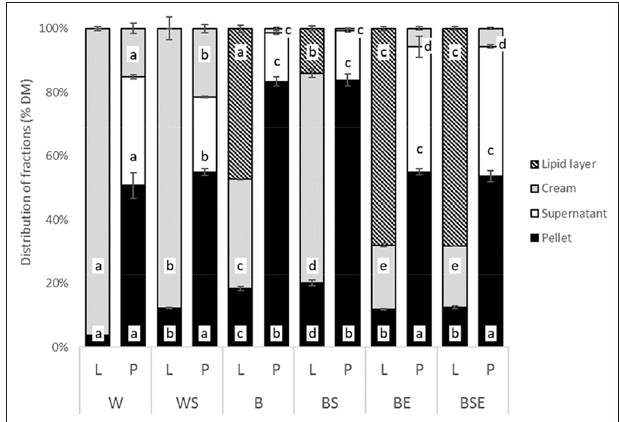
FIGURE 6 | Lipid (L) and protein (P) distribution (% w/w on dry matter). (W, washed; WS, washed and sonicated; B, blanched; BS, blanched and sonicated; BE, blanched and enzyme treated; BSE, blanched; sonicated and enzyme treated. n = 3, error bars represent standard deviations. Different letters in different fractions among L bars and P bars indicate statistical difference ( p <